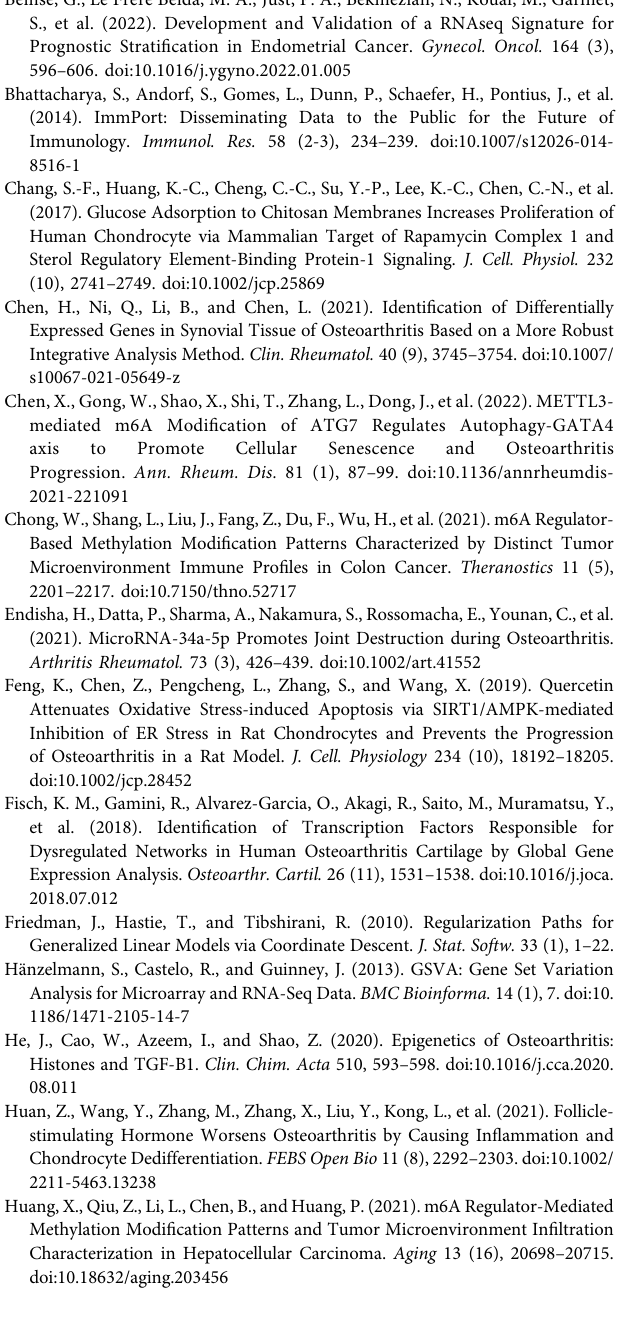
Supplementary Figure S1 | Differences in immune microenvironment characteristics between different m6A modi fi cation patterns. (A) Differences in the abundance of in fi ltrating immune cells in each immune microenvironment under the three M6A modi fi cation patterns. (B) differences in the activity of each immune response genome under the three M6A modi fi cation patterns. (C) HLA genes in the three m6A modi fi cations Expression differences in patterns. Supplementary Figure S2 | There are differences in the underlying biological functional characteristics of the three m6A modi fi cation patterns. (A,B) The